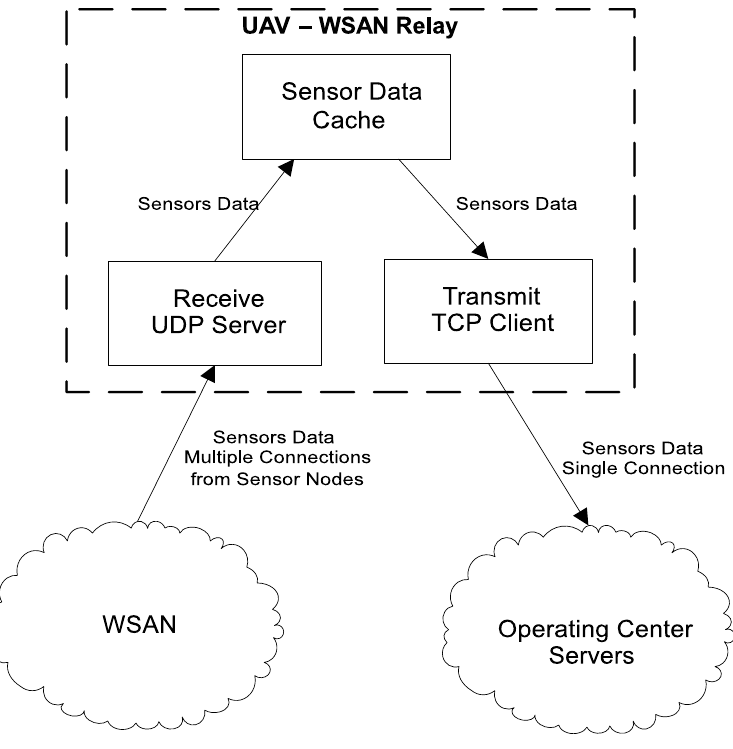
Figure 1. Schematic description of the UAV relay